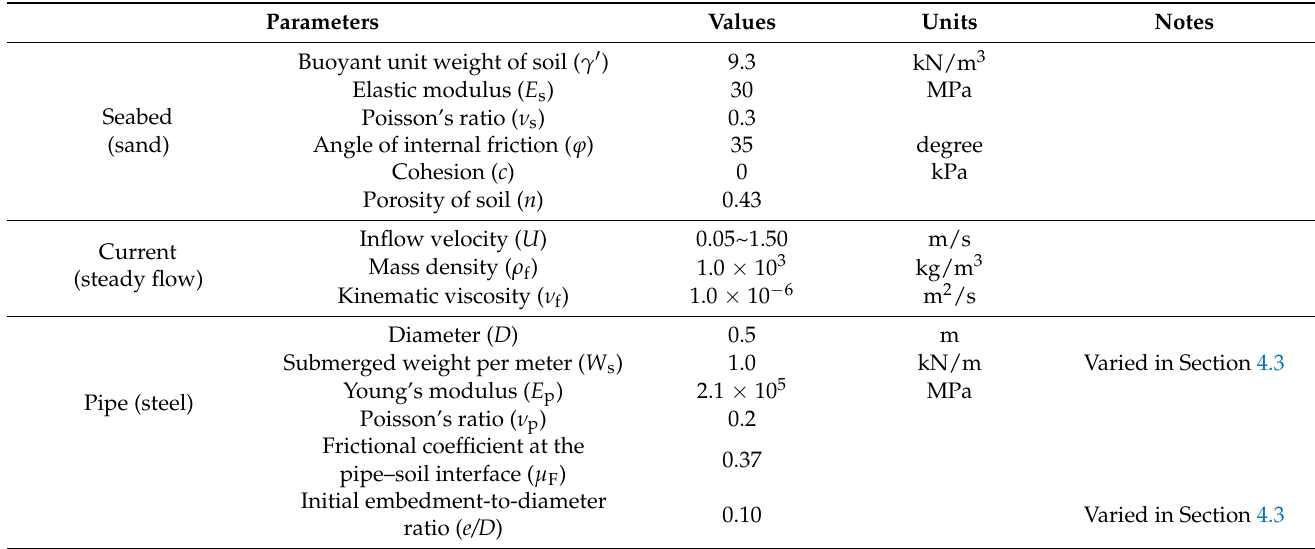
Table 1. Properties of the seabed, the current, and the